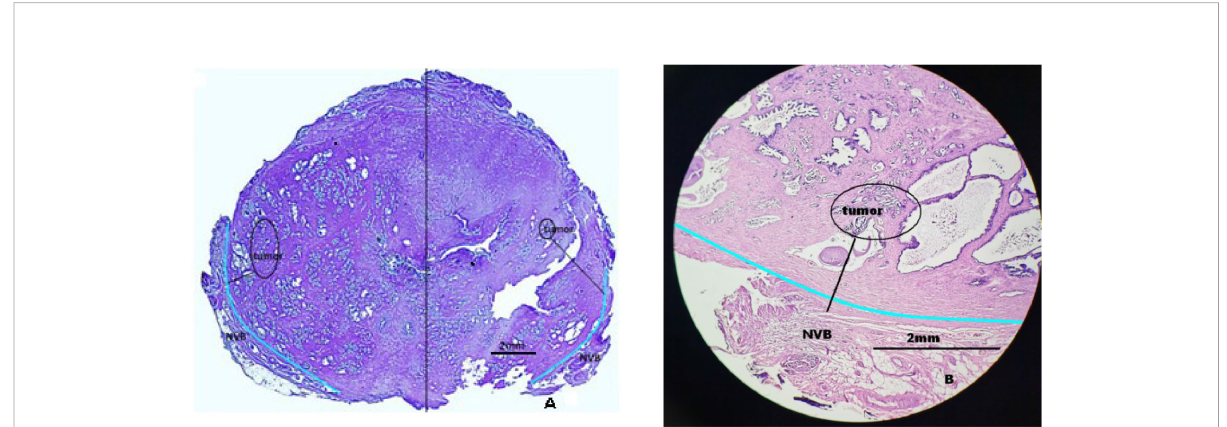
FIGURE 1 Schematic diagram of distance between the neurovascular bundle (NVB) and the foci of prostate cancer. (A) The measurement method of distance between the neurovascular bundle and the foci of prostate cancer: performed separately on the left and right sides. The light blue line is the prostate capsule (the junction of the gland and NVB). (B) The specimen measured the distance between the neurovascular bundle and the foci of prostate